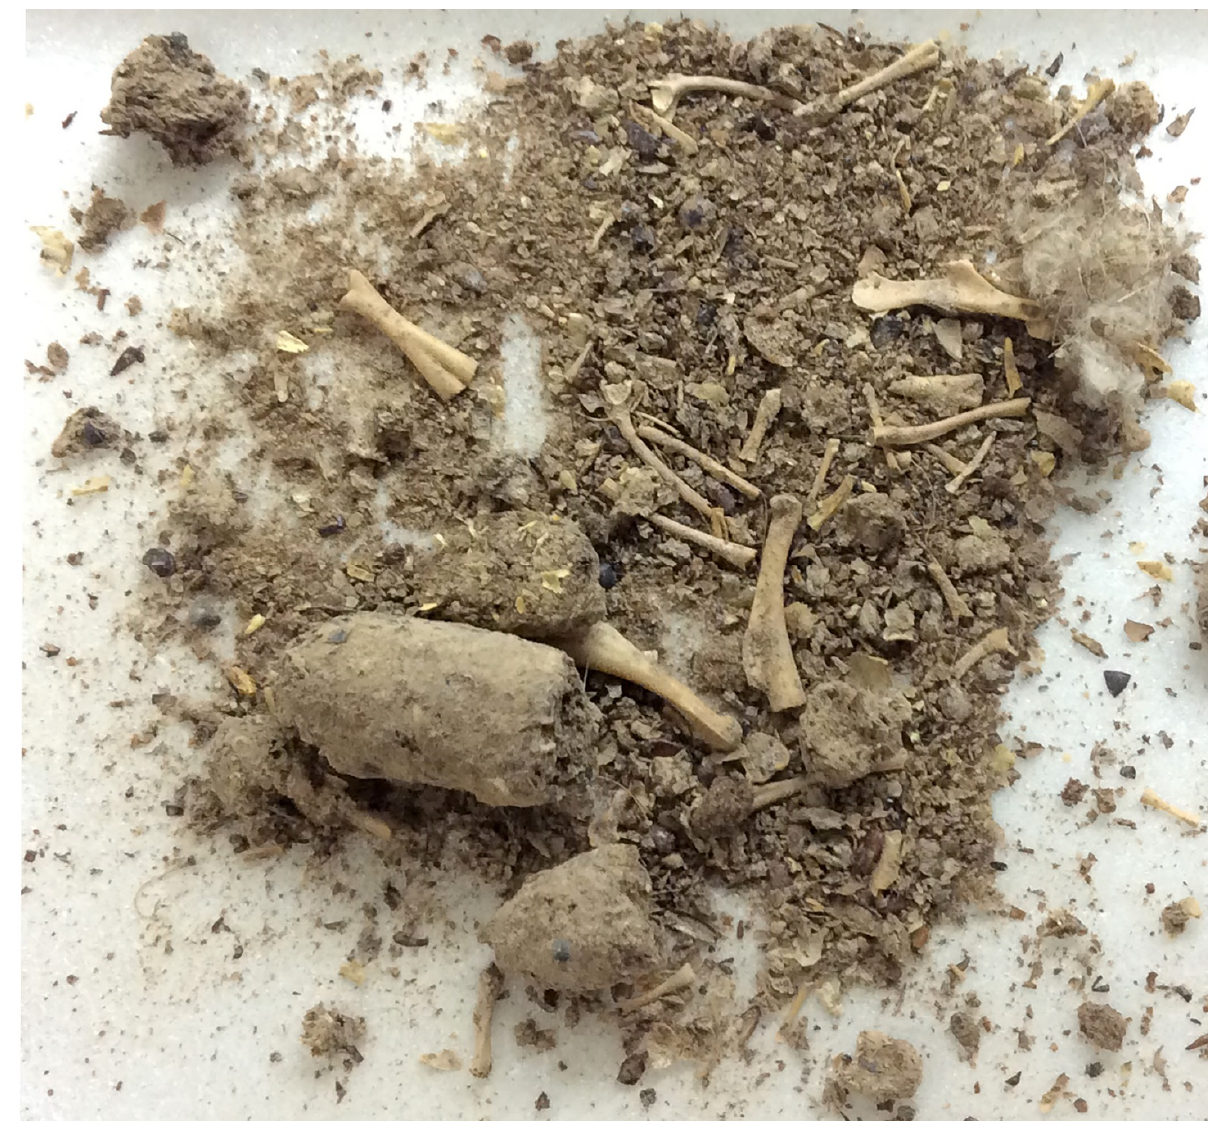
Figure 10. Owl pellet with Rhinella sp. remains from Rio Muerto tomb (M70B-4075) (photo by Susan D. deFrance).